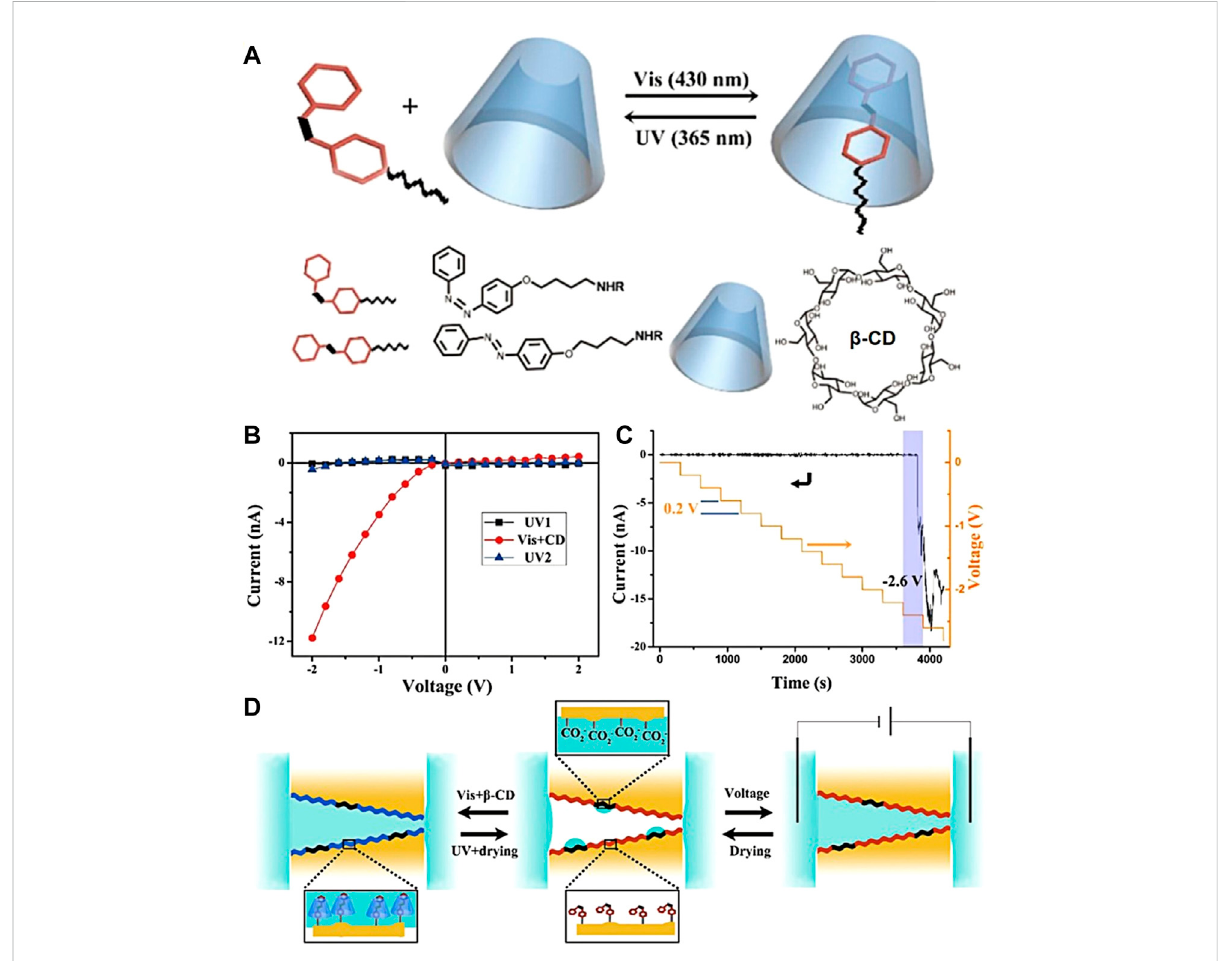
FIGURE 1 (A) Schematic diagram of optical inclusion and de-inclusion of azobenzene (Azo) derivatives and β -CD; (B) changes in ionic current in Azo modi fi ed nanochannels before and after β -CD assembly under UV and visible light; (C) hydrophobic nanochannels modi fi ed by Azo opened under − 2.6 V; (D) schematicdiagramoftheassemblyof β -CD-Azohost-guestcompoundsinnanochannelsregulatedbyphotoandelectricity (G.H.Xie,P. Li, Z. J. Zhao, Z. P. Zhu, et al., 2018) Copyright @ 2018